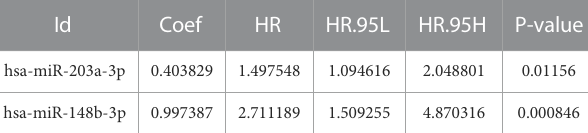
TABLE 5 miRNAs were obtained from multivariate Cox regression